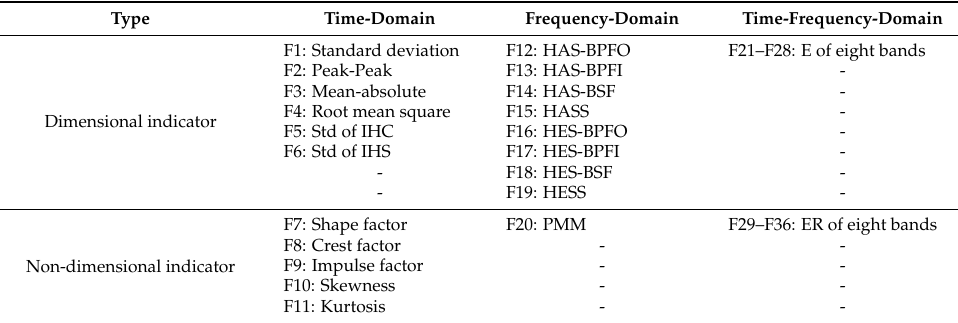
Table 1. Original features extracted from the de-noised vibration signals.